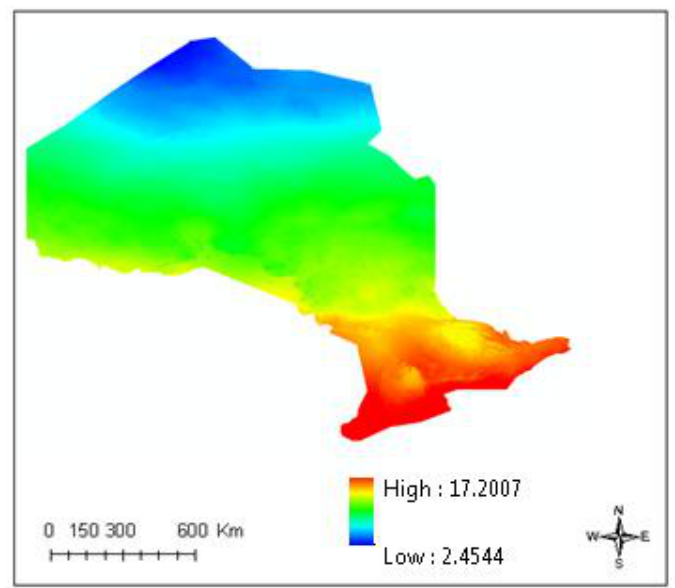
Figure 5. Maximum Temperature